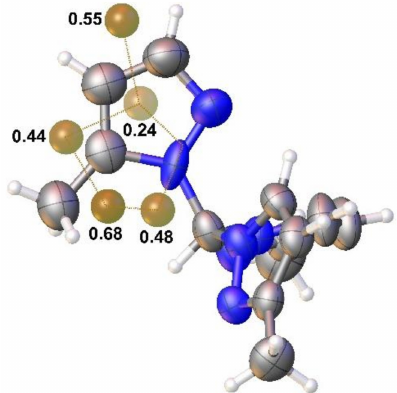
Figure 5. A view of the molecular structure of compound 335 showing the highest difference peaks (e Å − 3 ). Dotted lines joining these peaks mimic the disorder model observed and refined for the other crystal collected at low temperature.